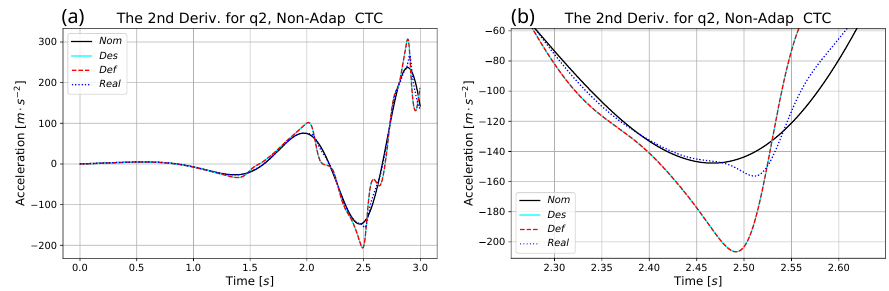
Figure 16. Second time derivatives for q 2 ( a ) and the zoomed-in excerpts ( b ) for the non-adaptive CTC controller using the identified parameters.